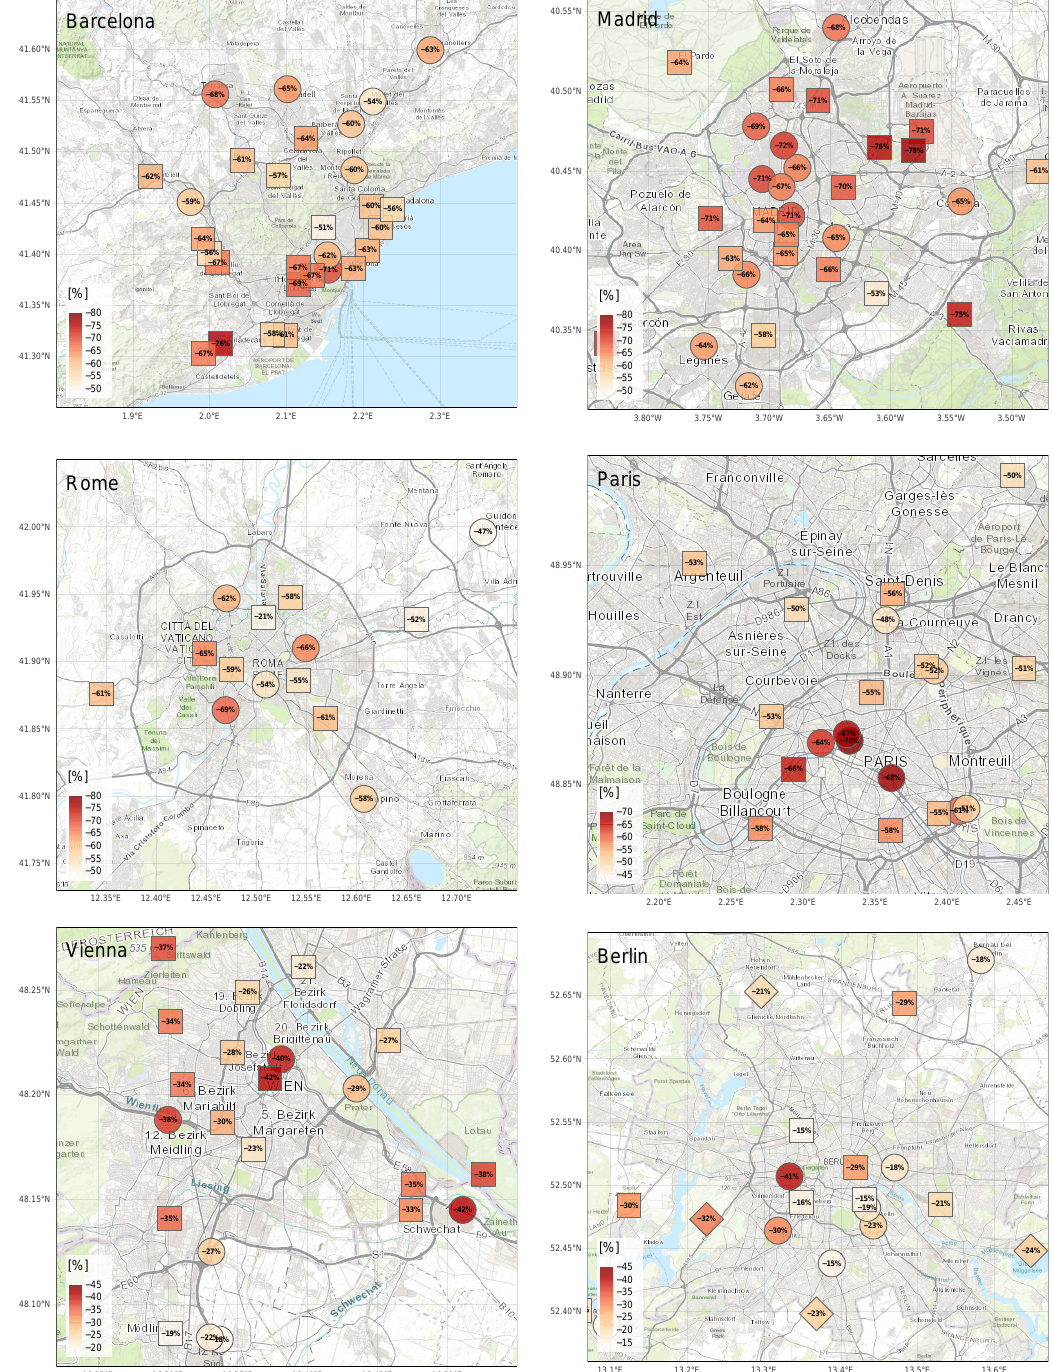
Figure 11. Relative reduction (in percent) of the observed NO 2 level for April 2020 compared to the business-as-usual scenario for all qualifying air quality monitoring stations in six selected cities (Barcelona, Madrid, Rome, Paris, Vienna and Berlin). Circles indicate traffic sites, squares indicate urban/suburban sites, and diamonds indicate rural sites. Note that the colour scale range varies between the panels to highlight the spatial patterns within a city better. In addition, note that in these maps, all stations within each domain are shown, whereas Figure 10 only shows stations selected according to a predefined list provided by EEA. Background base map by ESRI (Environmental Systems Research Institute) and